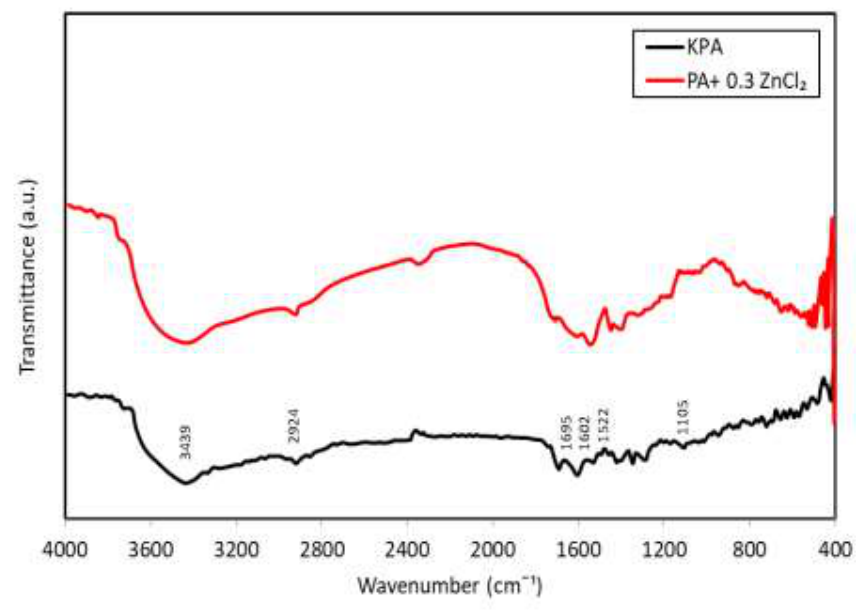
Figure 3: FTIR spectra of PAA and Zn-PA (0.3 g of ZnCl 2 ).